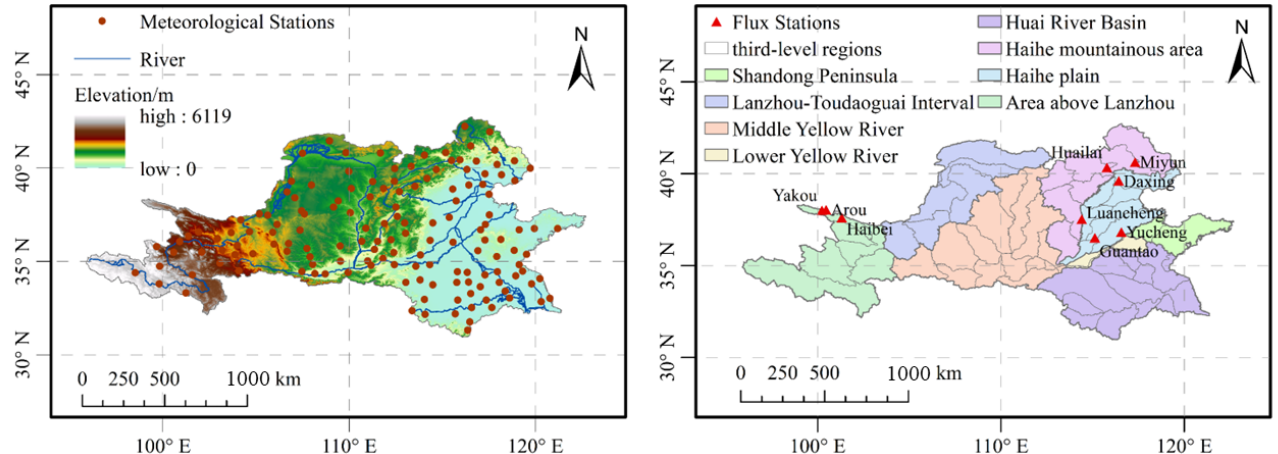
Figure 1. Zoning of Huanghuaihai River basin and distribution of meteorological stations.